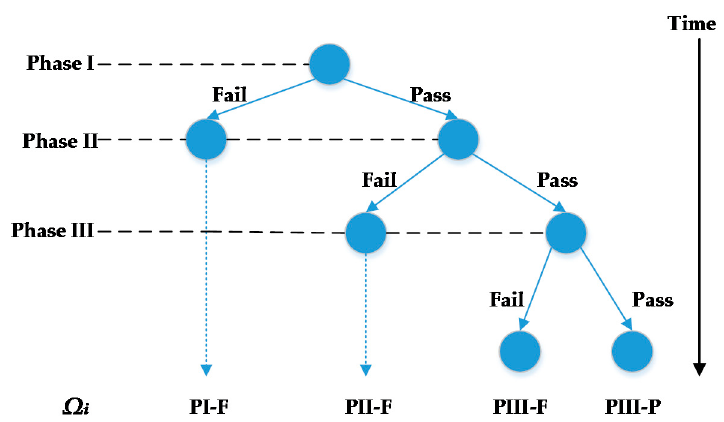
Figure 1. The outcome space of uncertain parameter associated with drug i , Ω i .